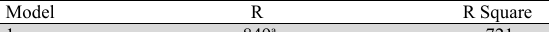
The results of R-Square value Model